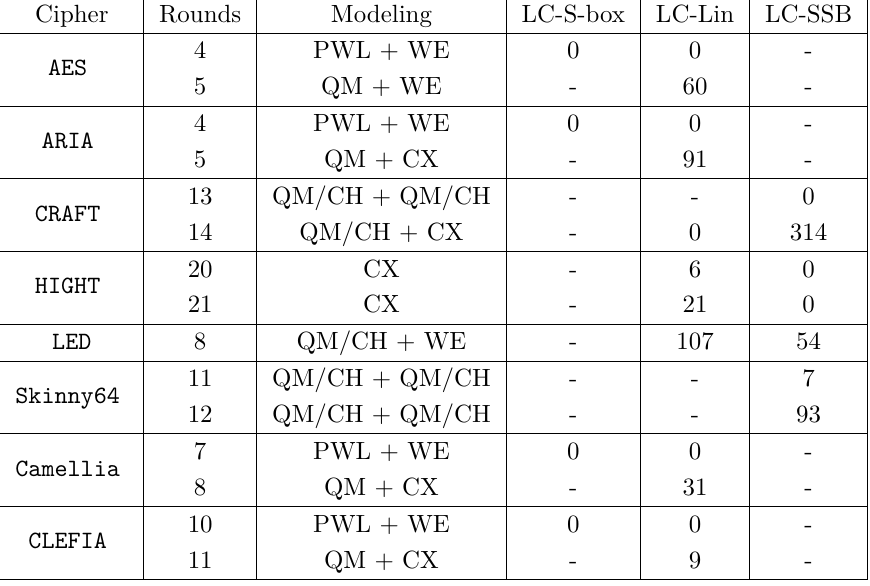
Table 3: Fastest modeling strategy and average number of lazy constraints added per input/output pair. LC-S-box, LC-Lin and LC-SSB denote respectively the average number of lazy constraints coming from the S-box, the linear layer and the Super S-box, when